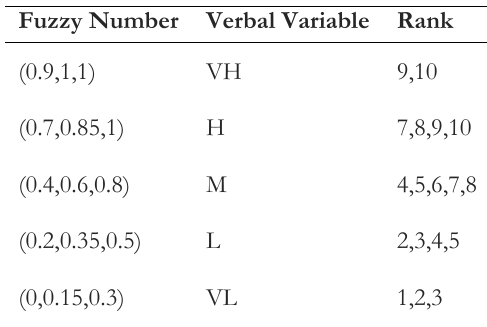
Table 1. Fuzzy numbers of linguistic variables corresponding to ranks 1 to